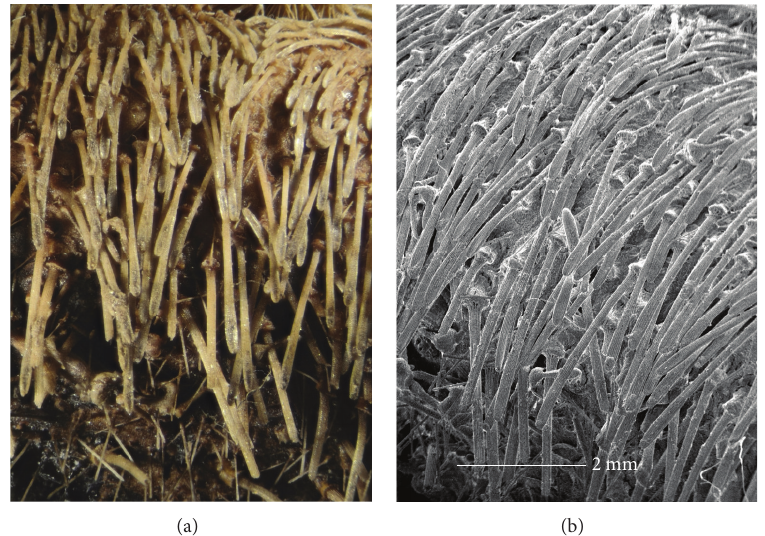
Figure 6: Anterolateral spines of Brisaster fragilis . (a) Stereomicroscope photograph; (b) SEM micrograph of the same area.